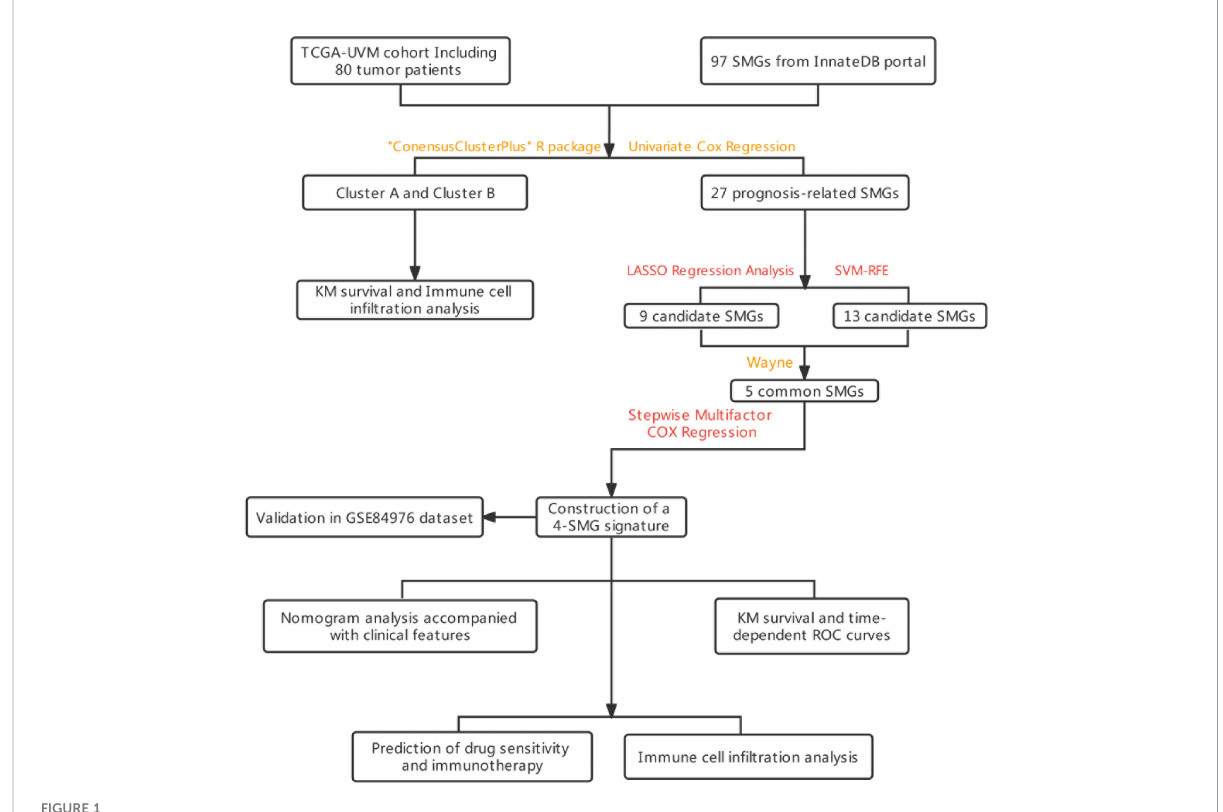
FIGURE 1 The fl owchart summarizes the main design of the present